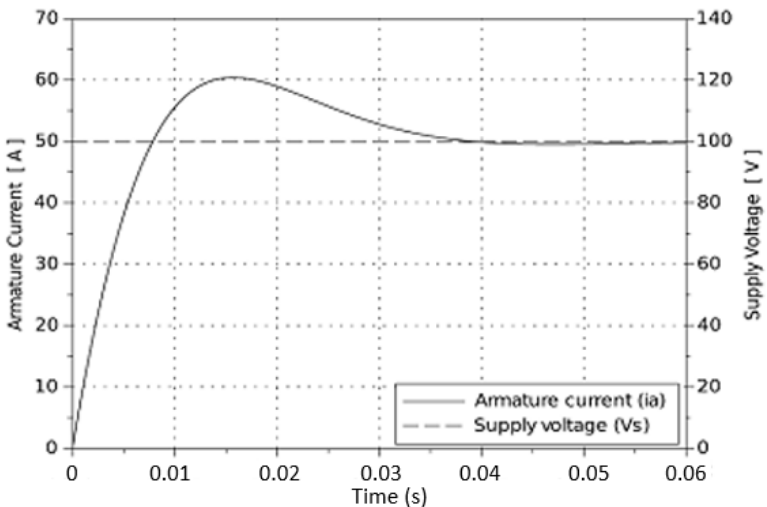
Figure 7. A simulation using Scilab of a constant supply voltage of v s = 100 V and the resultant armature current i a ( t ) under no-load conditions.